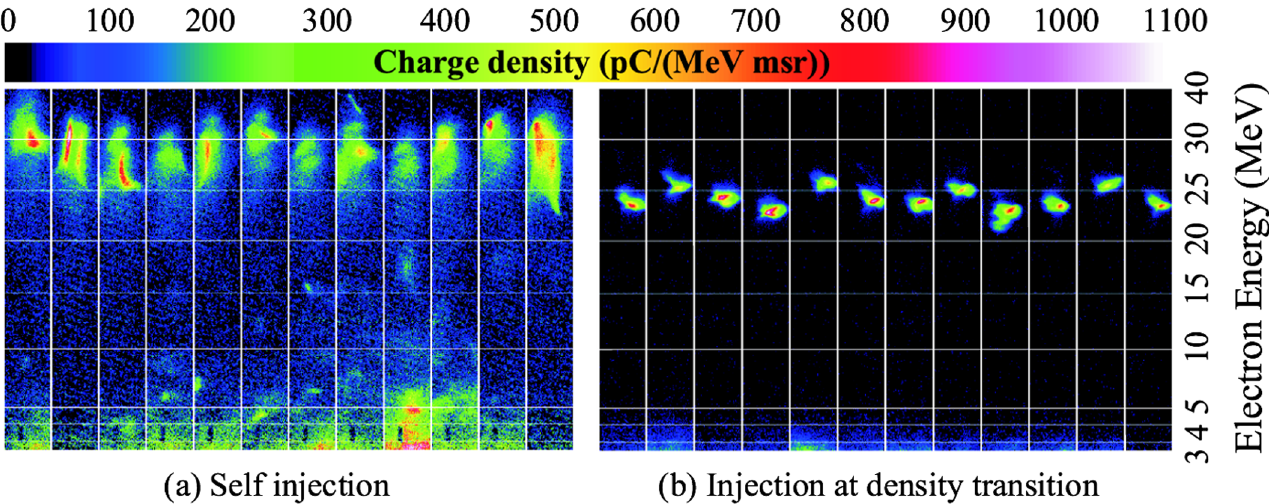
FIG. 2. A few shots representative for those 10% of all the shots with lowest energy spread for self-injection (a) and injection at a density transition (b). The horizontal axis in each image corresponds to the transversal electron beam size; the vertical axis shows electron energy. For self-injection the parameters of this fraction are 29 : 7 (cid:1) 1 : 2 MeV energy, 8 (cid:1) 5% energy spread, 10 : 0 (cid:1) 2 : 3 mrad divergence, and 3 : 1 (cid:1) 1 : 0 pC charge. For injection at the density transition, these values are 24 : 3 (cid:1) 0 : 9 MeV , 4 (cid:1) 0 : 5% , 7 : 3 (cid:1) 0 : 5 mrad , and 1 : 8 (cid:1) 0 : 5 pC ,